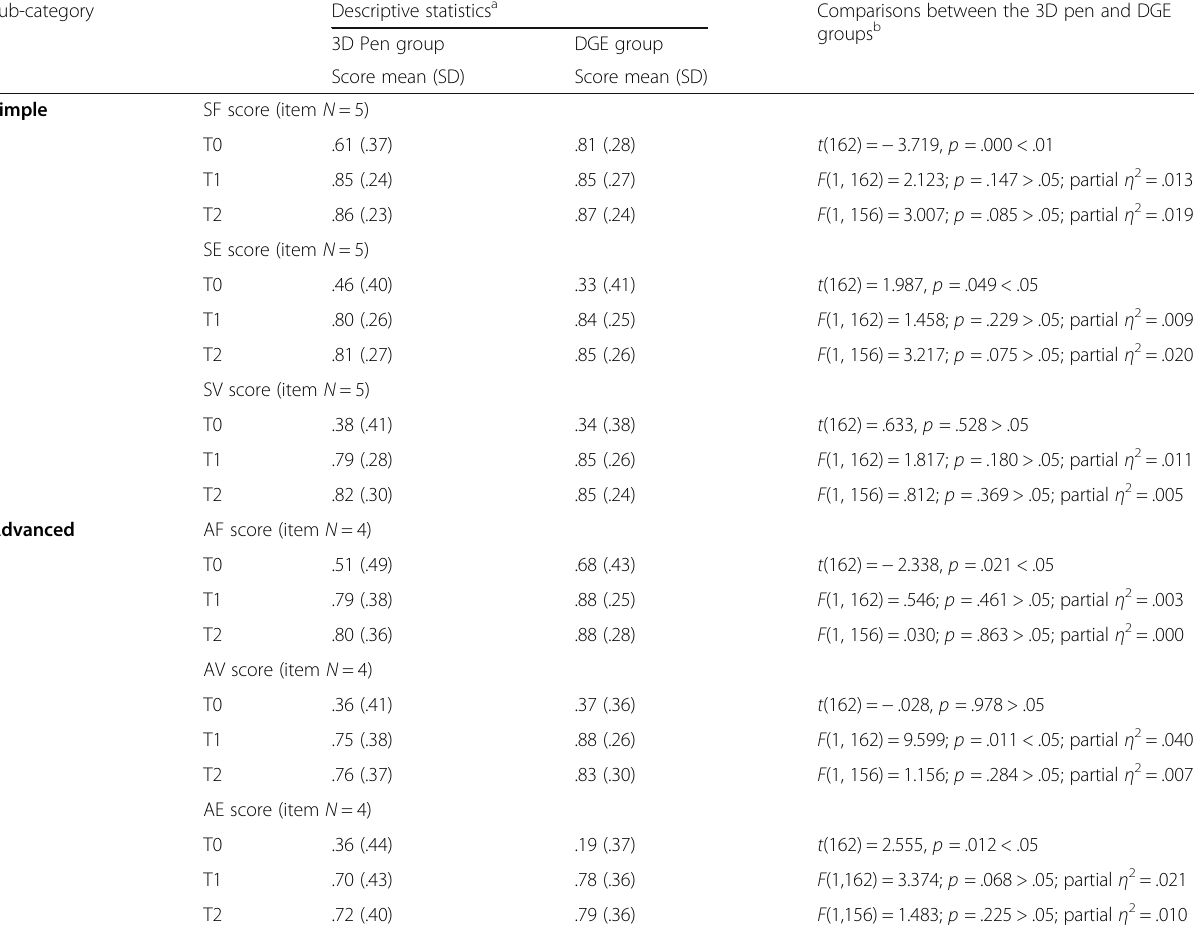
Table 4 Descriptive statistics and comparison between the 3D Pen and DGE groups (by sub-categories) Sub-category Descriptive statistics a Comparisons between the 3D pen and DGE